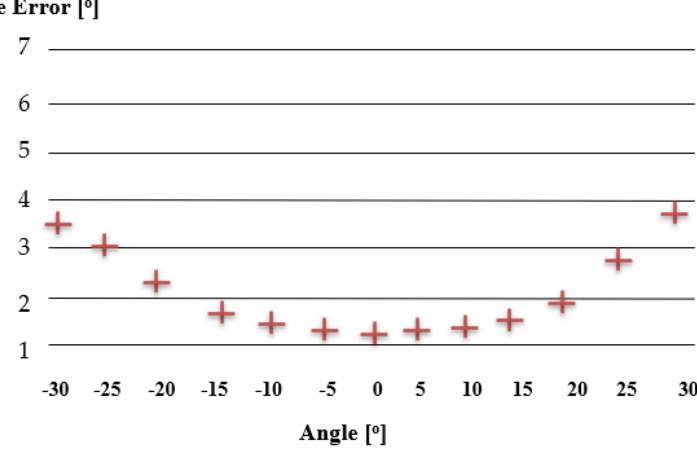
Figure 7. The results of gaze alignment error using the Kinect V2. The horizontal axis is the difference of various angles used in the experiment, while the vertical axis indicates the angle error of gaze alignment.